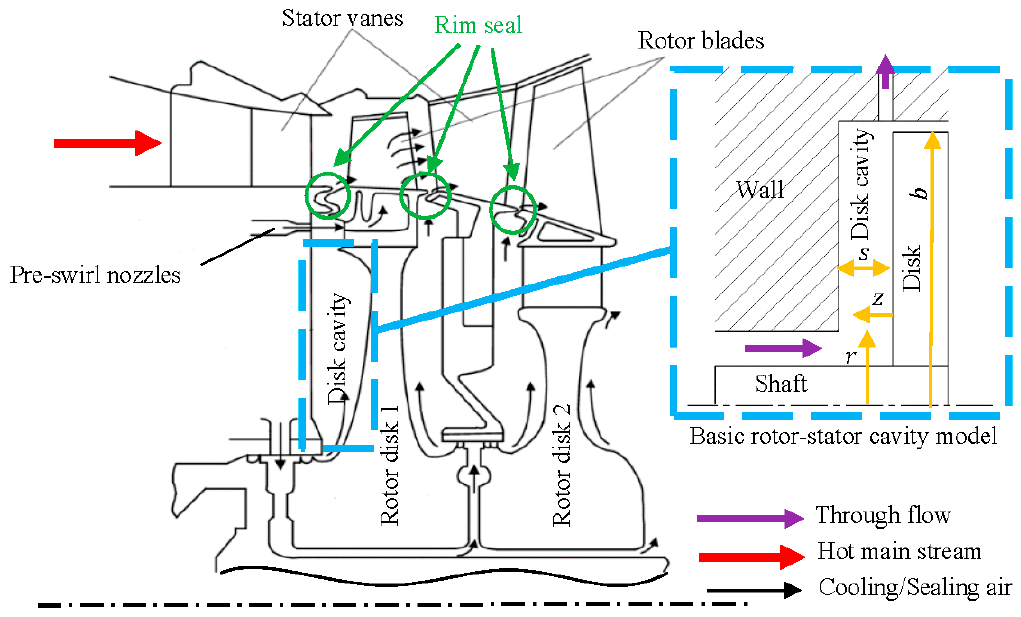
Figure 1. The sketch of the disk cavity in a gas turbine. 𝑧 : axial coordinate (m), 𝑟 : radial coordinate (m), 𝑠 : axial gap width of the front chamber (m), 𝑏 : effective outer radius of the disk (m).